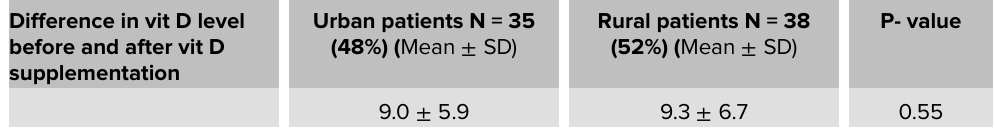
TABLE 3: Vit D level among urban and rural patients.